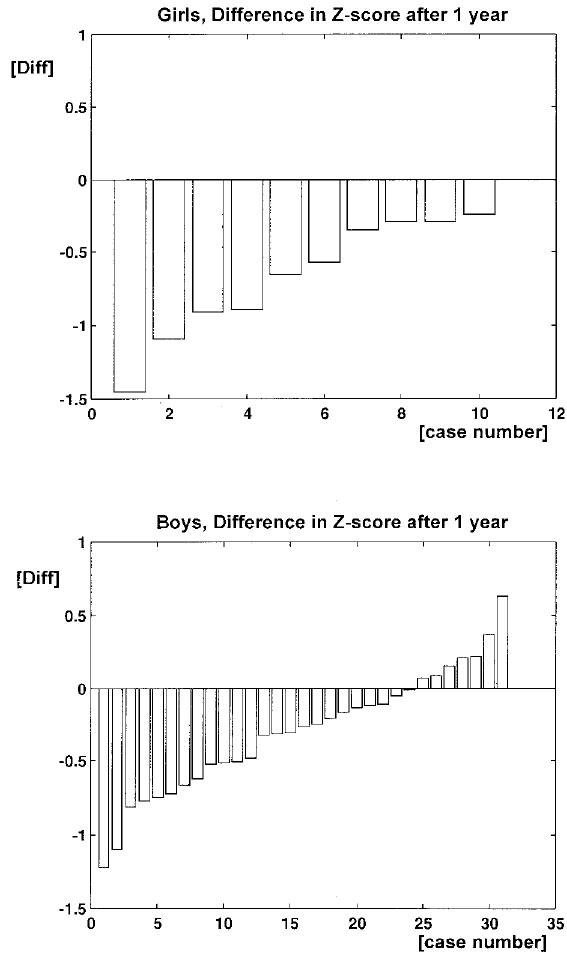
Fig. 5. Height at skeletal maturity in 19 children who have been treated for an osteosarcoma in the area of the knee plotted in the growth charts for the normal population. Fig. 4. Difference in standard deviation score after 1 year in 41 children who had their height estimated at diagnosis and after 1 year. A negative value indicates that the child had a less than average growth for age and gender .